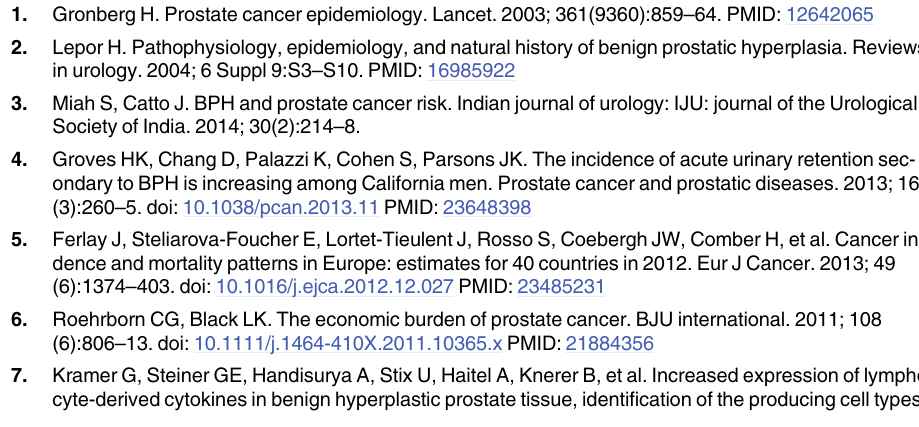
S1 Table. List of autoantigens included in the planar protein microarray (Table "Protein Array") and in the Luminex bead protein array (Table "Luminex"). Autoantigen proteins included in the planar protein array or in the Luminex bead protein array are listed. The num- ber of positive samples of indivual auoantigens for the low and the high inflammation cohorts (colums D,E), p-values for the discrimination of the low and high inflammation samples (colums F) and mean fold changes, high compared to low inflammation samples (colums G) are listed. Autoantigens are ranked according to p-values. S2 Table. List of 165 significantly upregulated autoantibodies in serum samples of the screening cohort, ranked according to